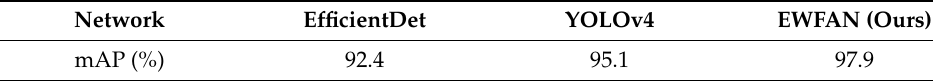
Table 6. Results of different network on our validation